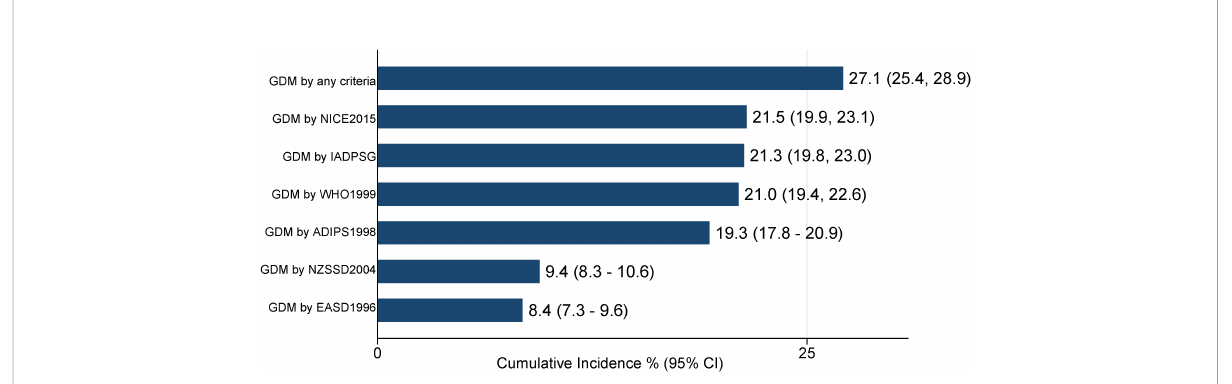
FIGURE 1 GDM cumulative incidence among pregnant women using six GDM diagnostic criteria (N = 2,546). IADPSG, International Association of Diabetes and Pregnancy Study Groups; NICE, National Institute for Health and Clinical Excellence; WHO, World Health Organization; ADIPS, Australasian Diabetes in Pregnancy Society; EASD, European Association for the Study of Diabetes; NZSSD, New Zealand Society for the Study of